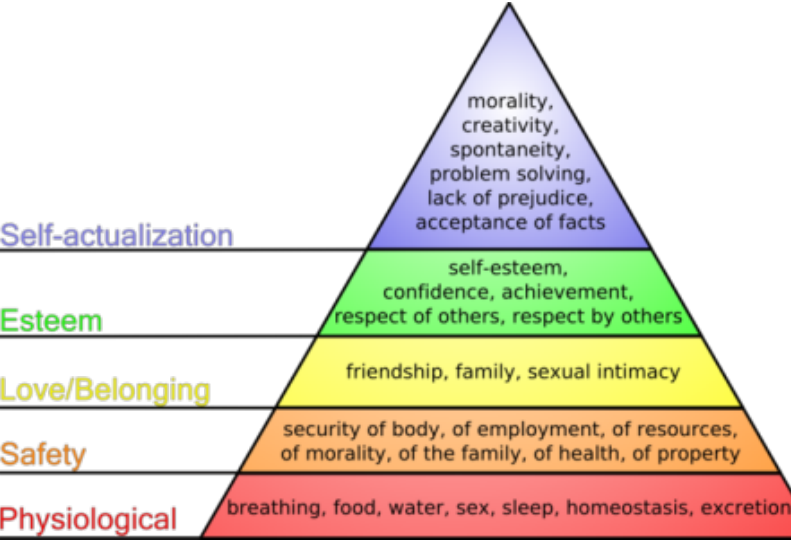
Fig. 7. Maslow’s Hierarchy of